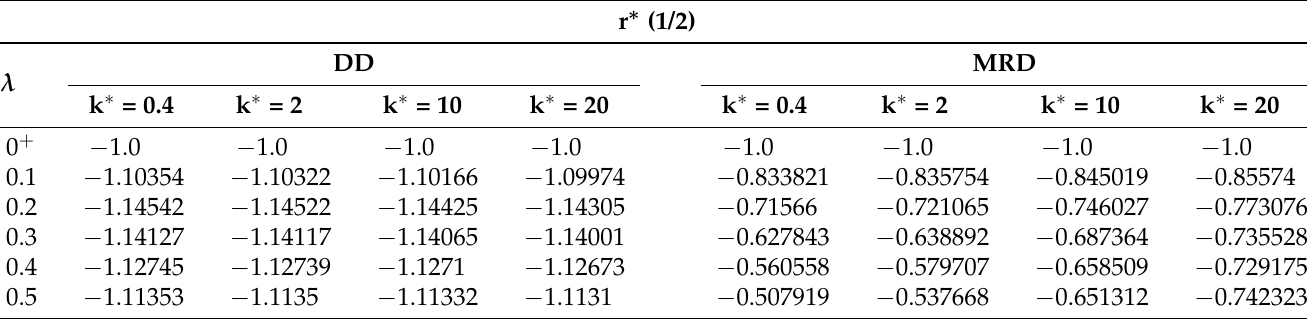
Table 2. Free beam subjected to a non-dimensional uniform load q ∗ y = − 1. Non-dimensional midpoint foundation reaction r ∗ ( 1/2 ) versus the non-dimensional length-scale parameter λ evaluated by the non-dimensional Winkler parameter k ∗ ∈ { 0.4,2,10,20 } in the DD and MRD